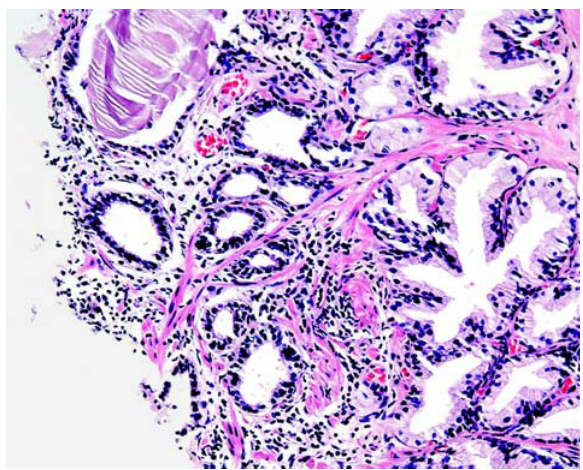
Figure 1 – Atrophy with no inflammation, hyperplastic subtype (HE, X100).